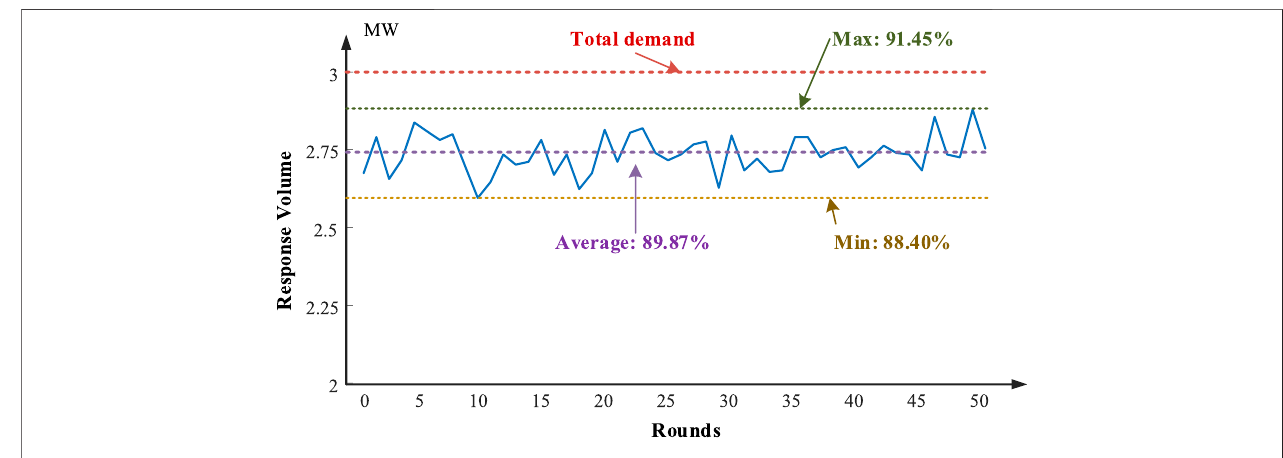
FIGURE 14 | Response results of 50 rounds with the strategy.